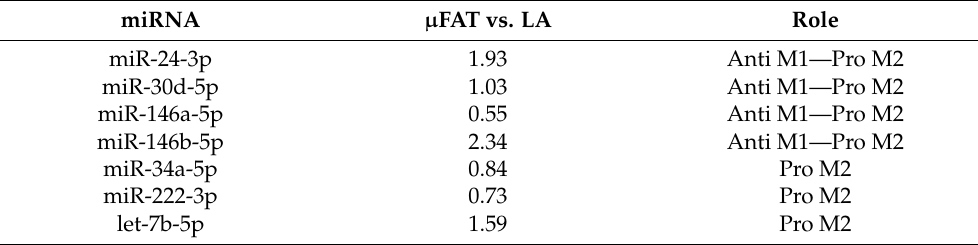
Table 2. Pro M2 anti-inflammatory macrophage miRNAs in LA-EVs and µ FAT-EVs first quartile. miRNA µ FAT vs.